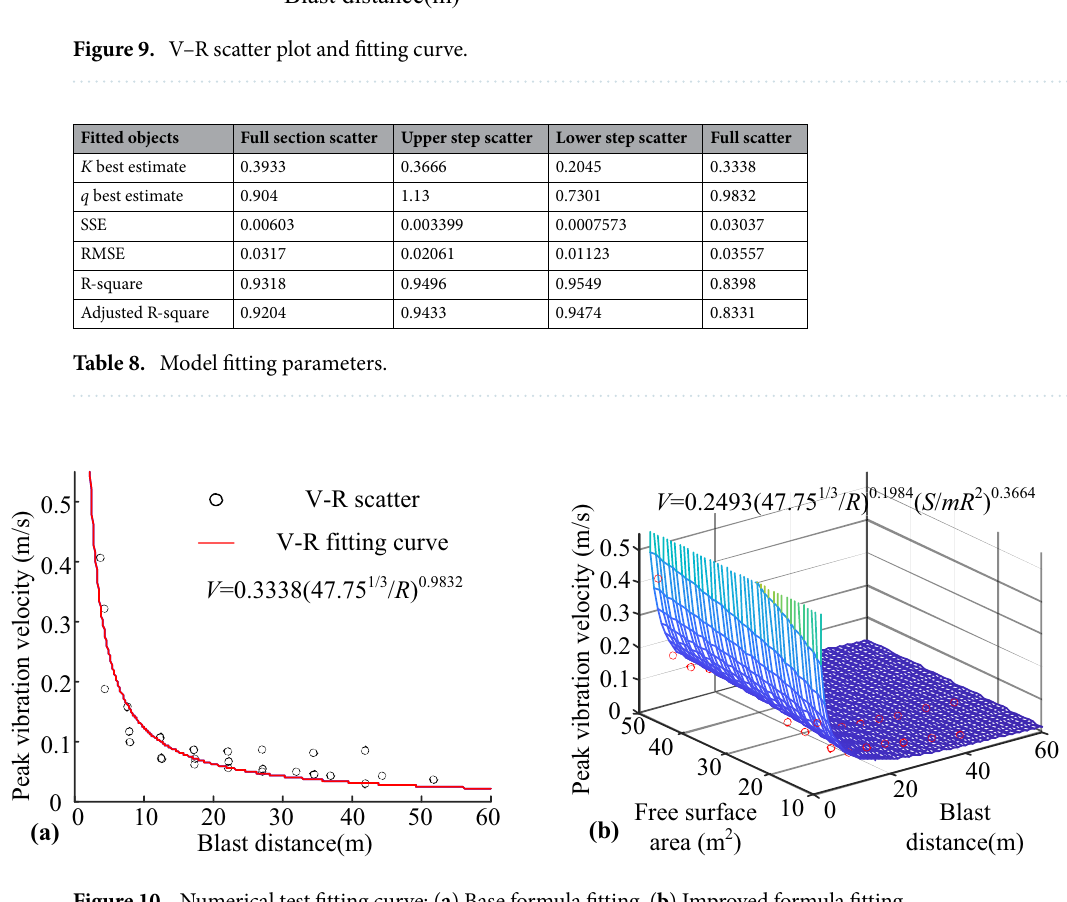
Figure 10. Numerical test fitting curve: ( a ) Base formula fitting. ( b ) Improved formula fitting.